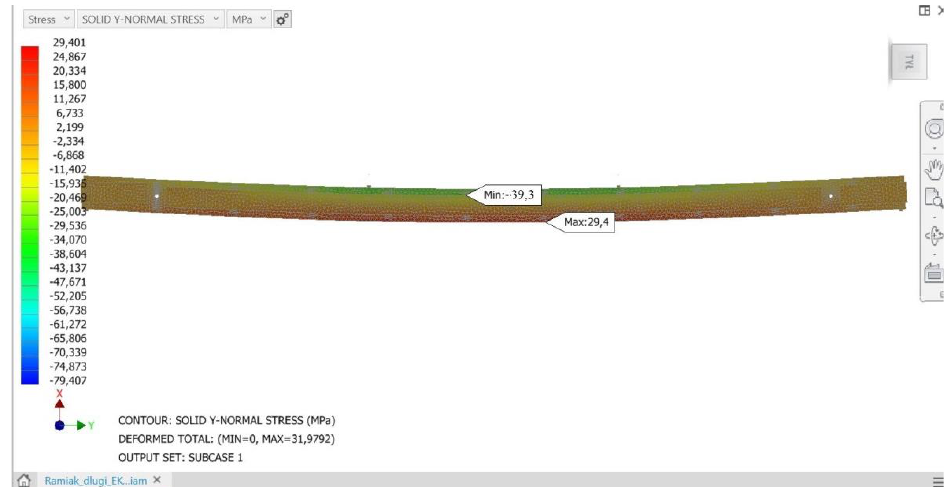
Figure 6. Mesh (computational) model of a version B frame made of glued material with a finger-jointed lamella length of 200 mm, together with the distribution of the normal stress map.